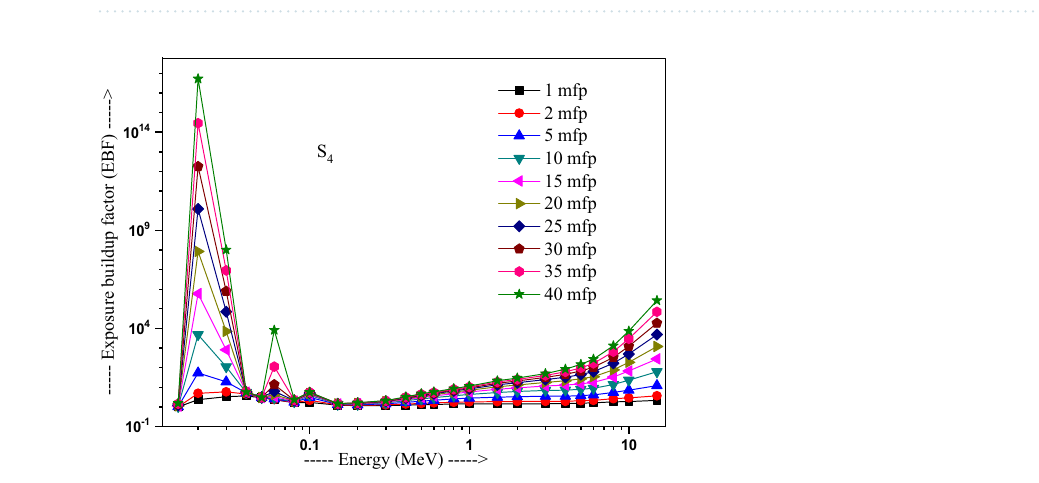
Figure 12. Variation of exposure buildup factor with energy for 20Bi 2 O 3 − xPbO − (80 − 2x)B 2 O 3 − xGeO 2 (x = 20) glass (S